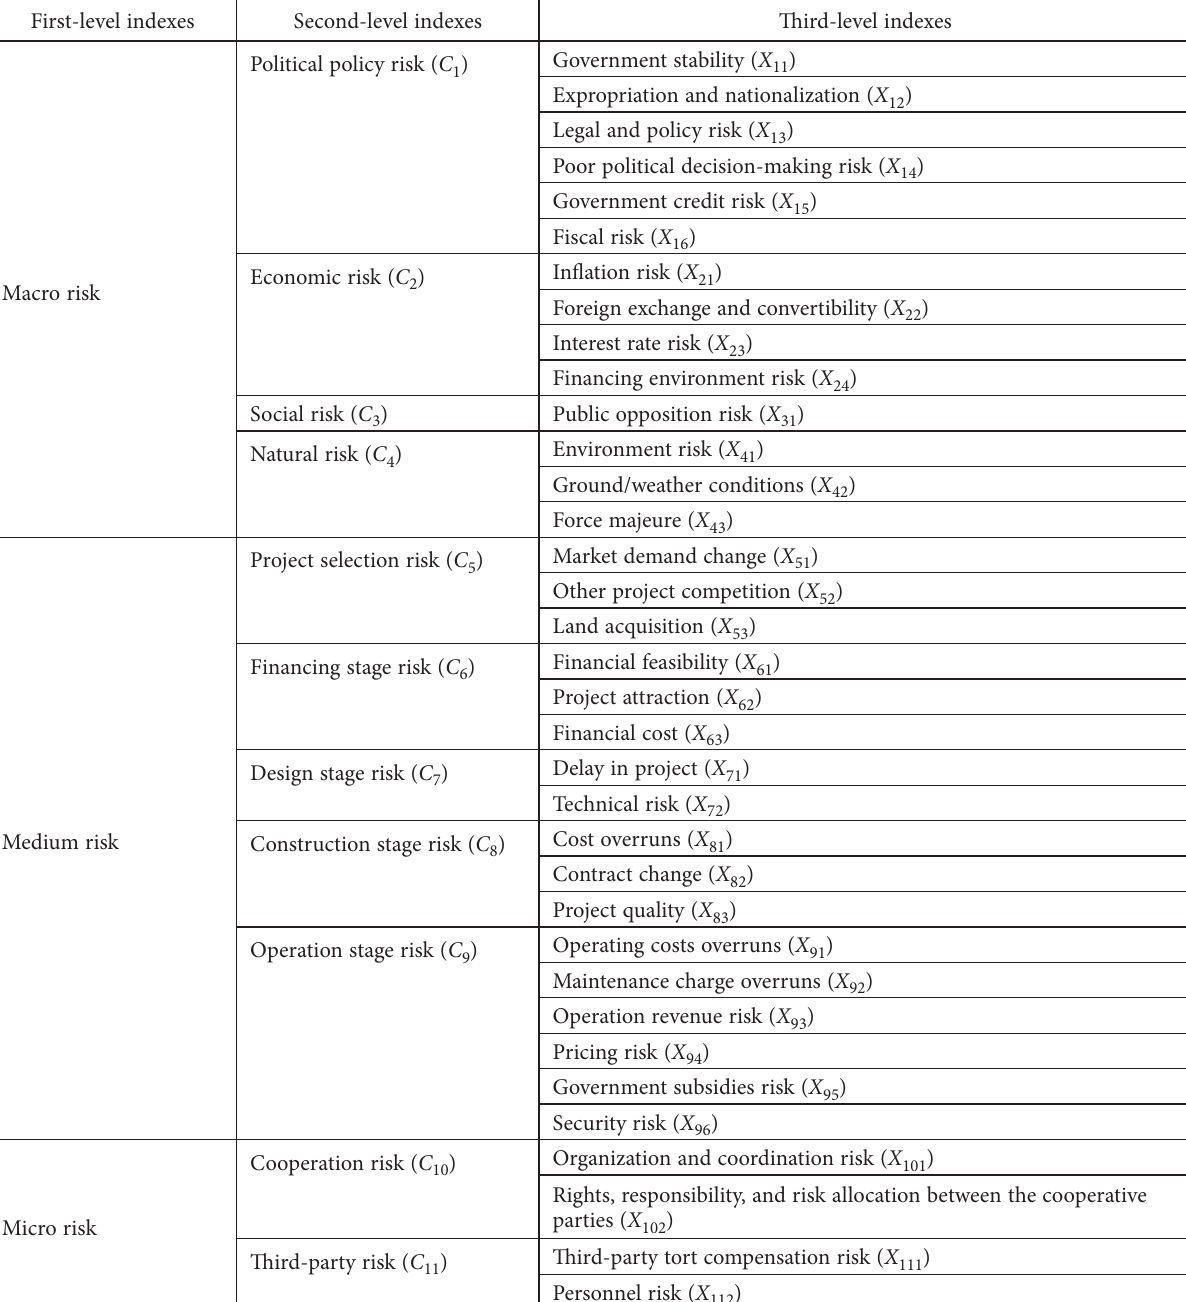
Table 3. Risk index system for PPP